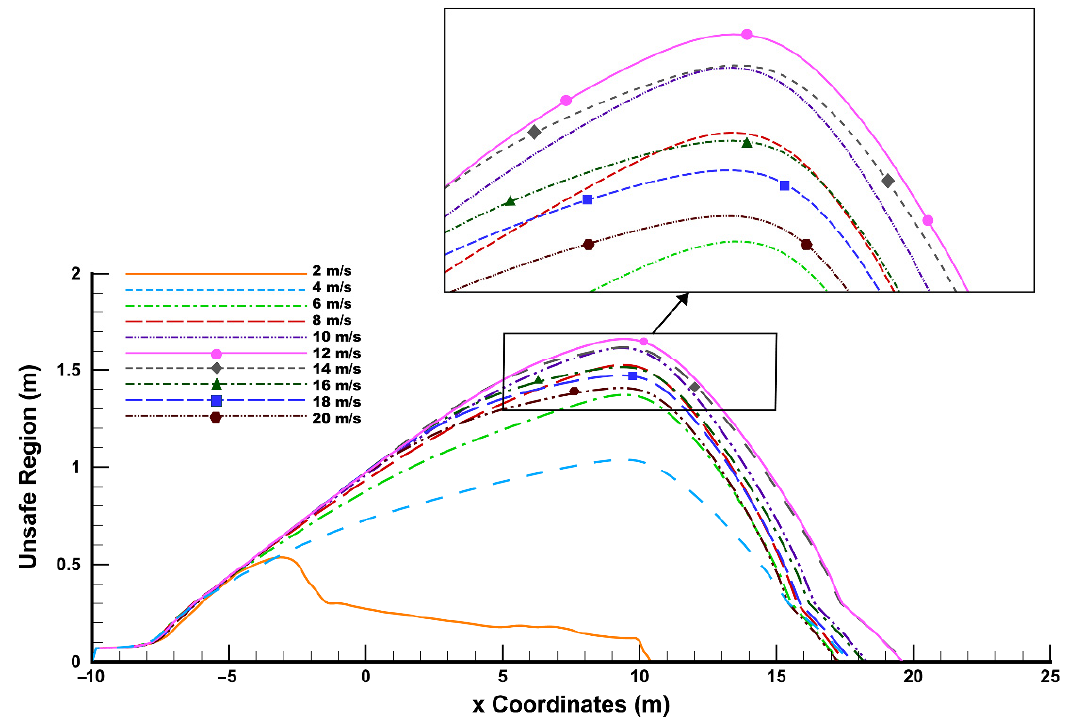
Figure 10. Unsafe regions where H 2 S concentration was higher than 10 mg/m 3 .